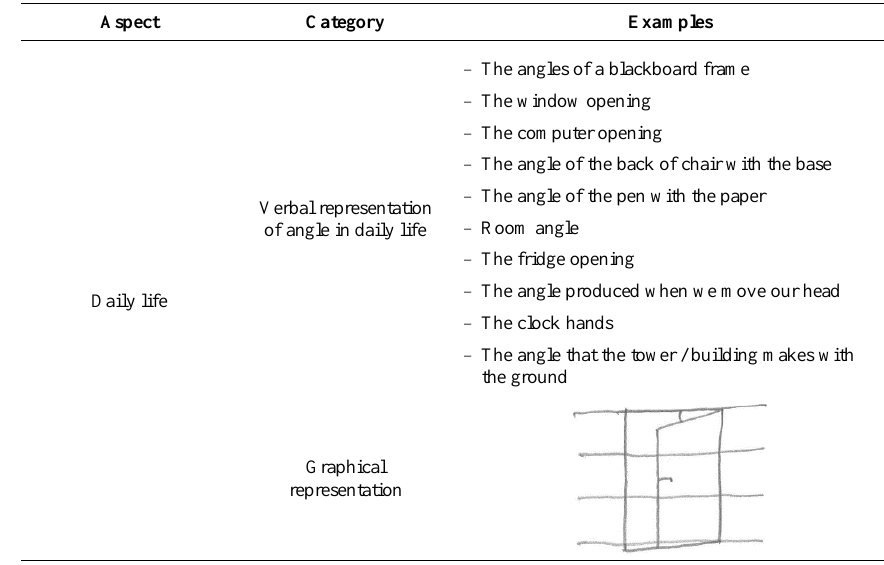
Table 3. Analysis examples of categories taken from the